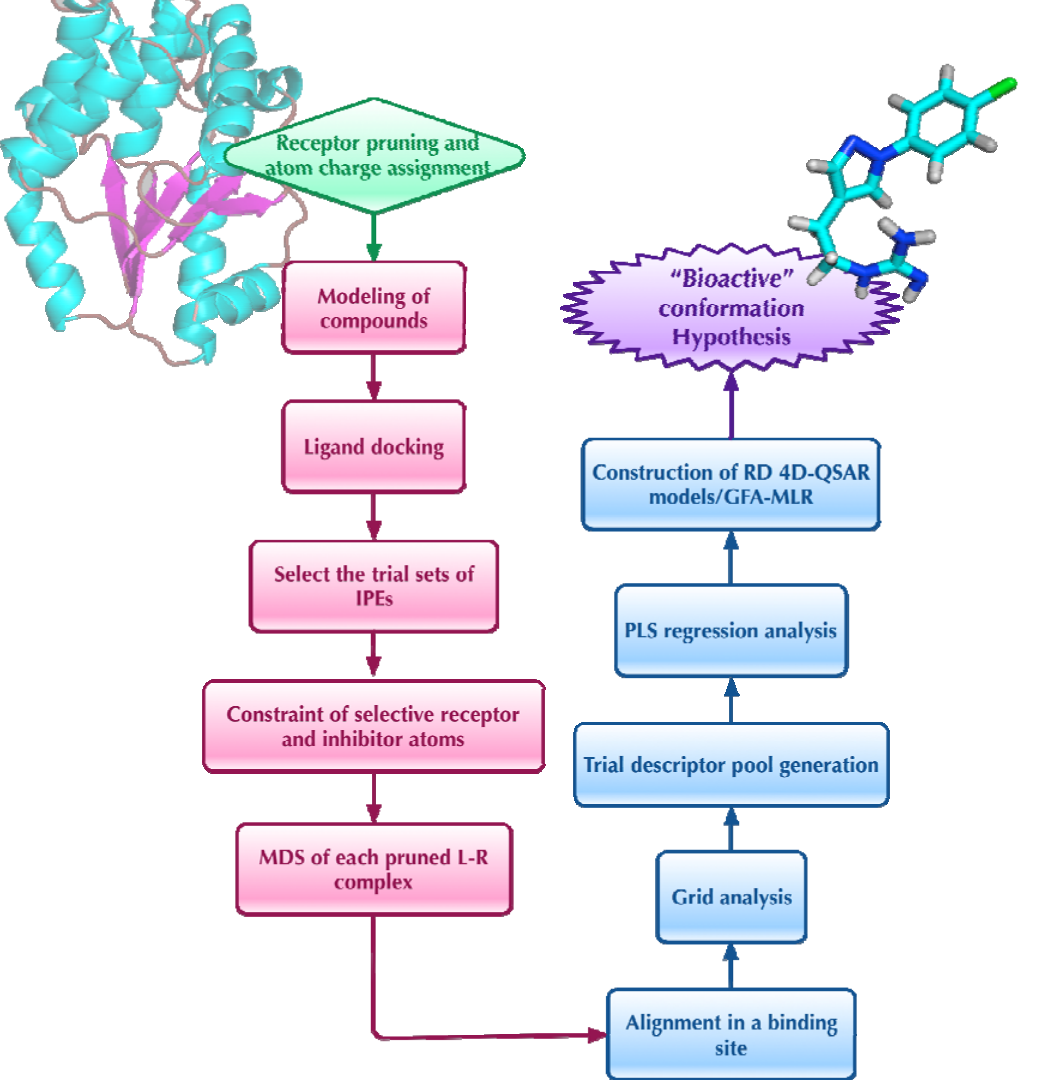
Figure 4. Operational steps in performing a RD-4D-QSAR